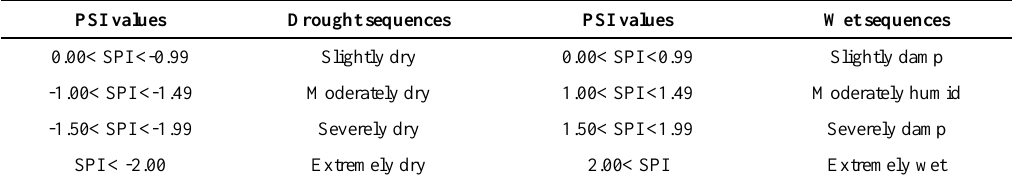
Table 1. Classification of drought sequences according to SPI